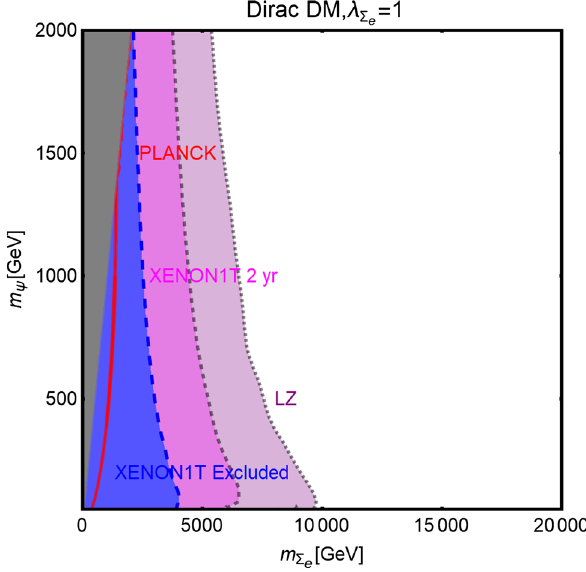
Fig. 18 The same as the top panel of Fig. 17 but for a scalar mediator with the same quantum numbers as of the right-handed charged